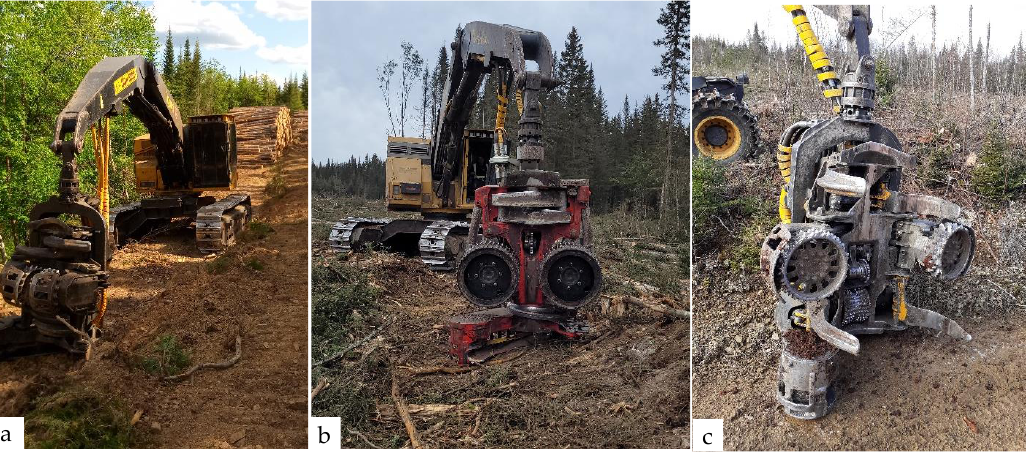
Figure 3. Harvesting heads used in the study, ( a ) Ponsse H8HD; ( b ) LogMax6000V; ( c ) Ponsse H7.